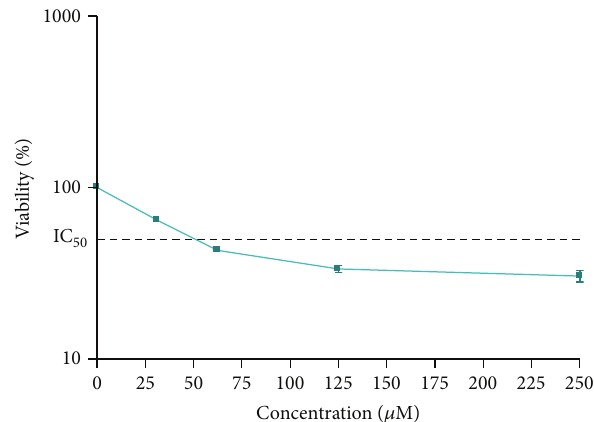
Figure 1: The effect of H 2 O 2 on H9c2 cell viability. The cell viability was determined by MTT assay as described in material and methods. Data are expressed as the mean ± SEM of three separate experiments ( 𝑛 = 6